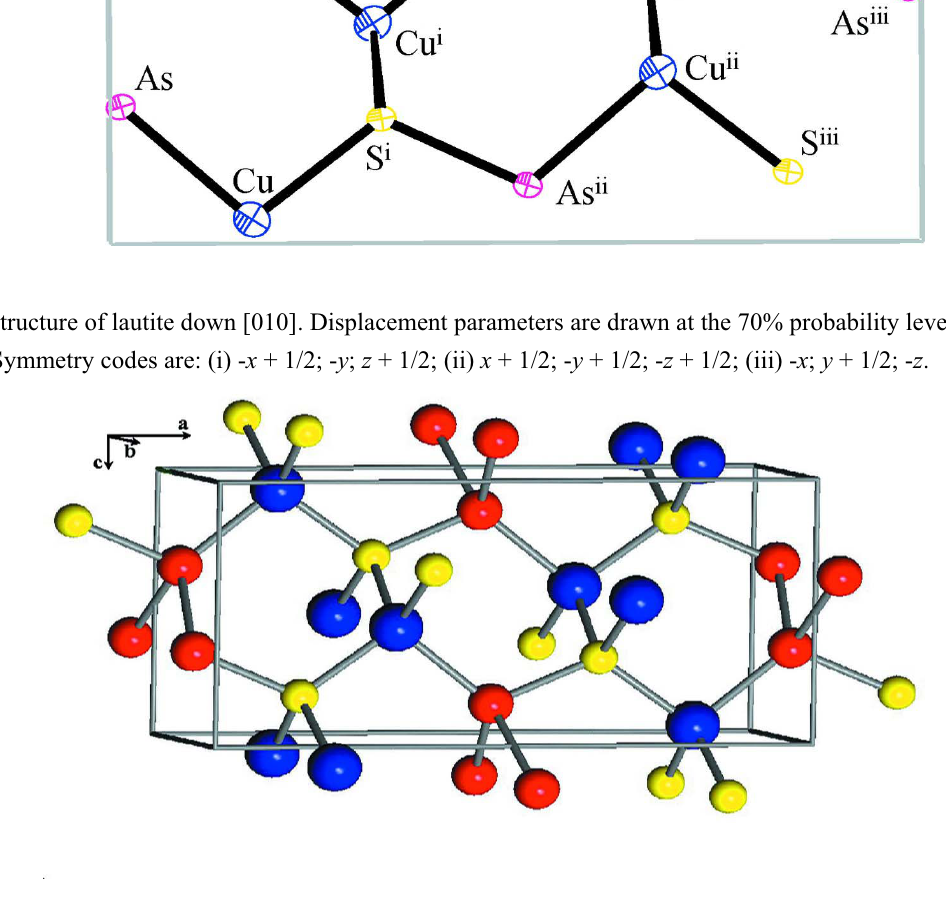
], As[CuAs S] and S[Cu As] tetrahedra. Blu, red and 3 2 3